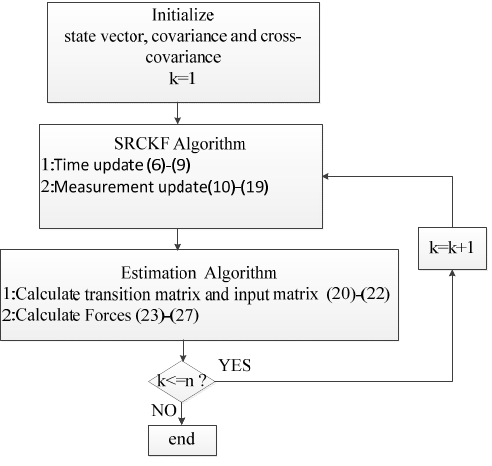
Figure 1. The flow chart of estimation method.